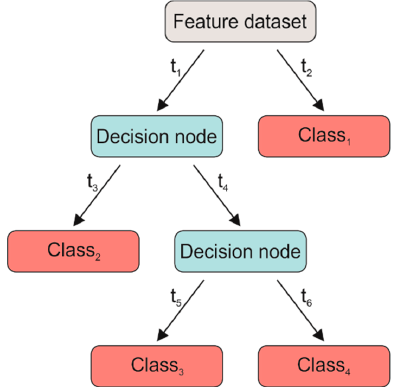
Figure 4. Scheme of a generic decision tree (DT). t i represent the thresholds of the splitting. Grey rectangle represents the input, red ones represent the outputs, and blue ones represent the decision nodes where the rules of the classification are applied.